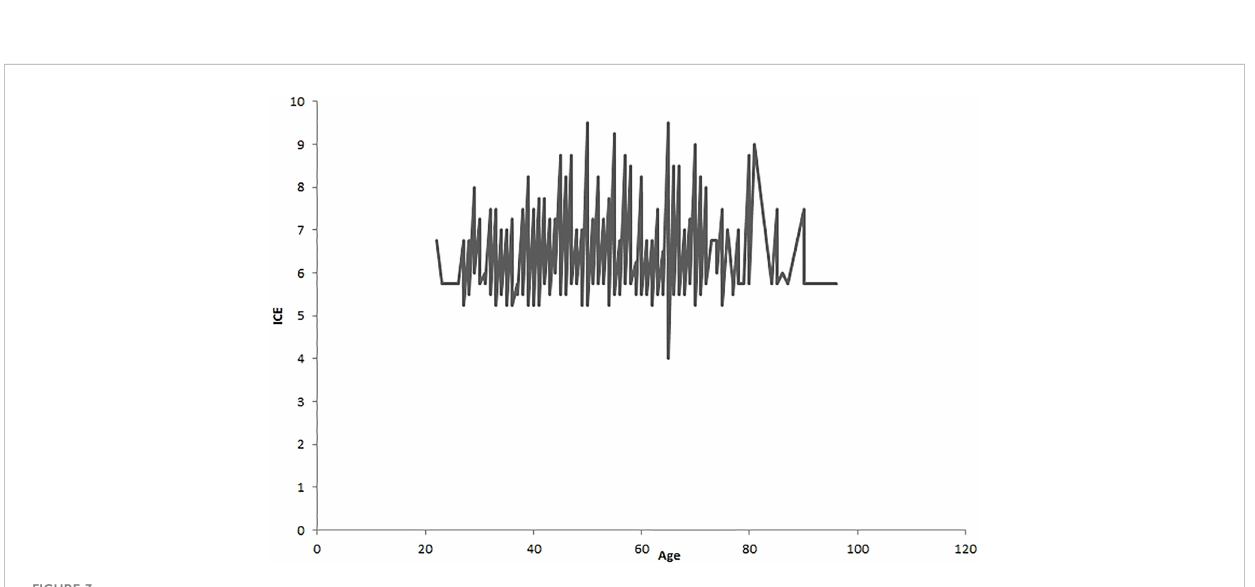
FIGURE 3 Ethnomedicinal knowledge variation by